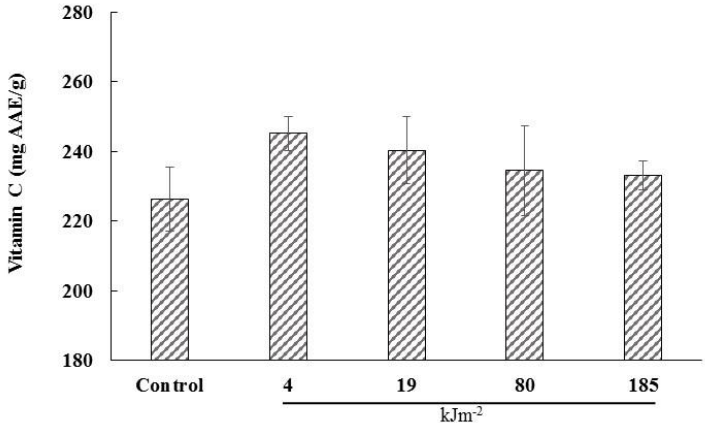
Figure 3. The effect of different UV-C irradiations on the vitamin C (ascorbic acid) content of the aqueous lemon pomace extracts. The values are the mean of three replications.